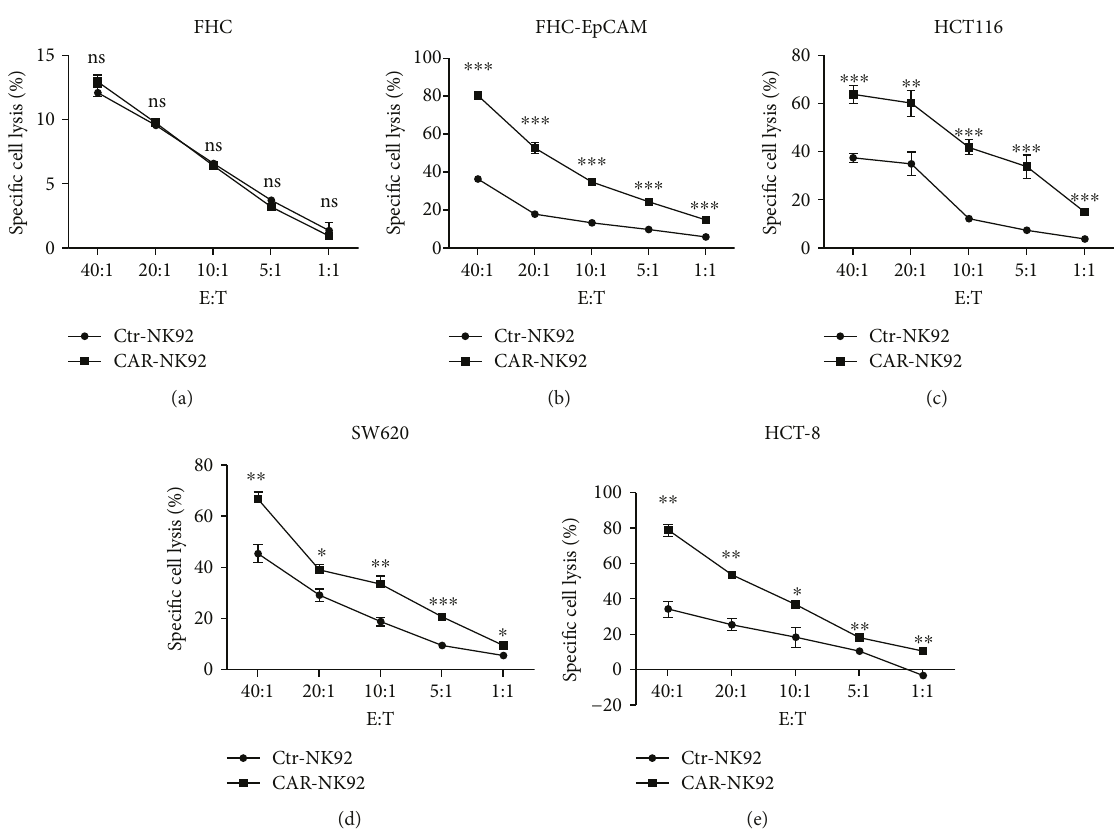
Figure 3: Speci fi c cytotoxicity exhibited by EpCAM-speci fi c CAR-NK-92 cells against EpCAM-positive target cells. The cytotoxic activity of CAR-NK-92 and Ctrl-NK-92 cells against EpCAM-negative or EpCAM-positive cells was determined using a 4-hour lactate dehydrogenase (LDH) release assay in a dose-dependent manner. ∗ p < 0 05 ; ∗∗ p < 0 01 ; ∗∗∗ p < 0 001 ; ns: not signi fi